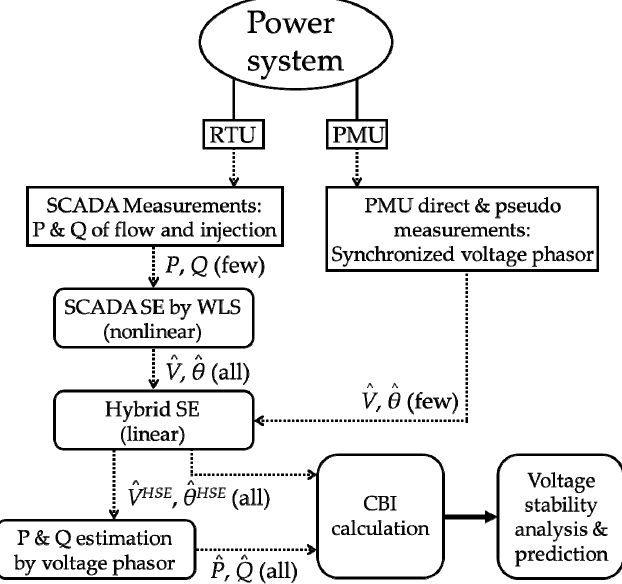
Figure 3. The Critical Boundary Index (CBI) estimation flow chart.